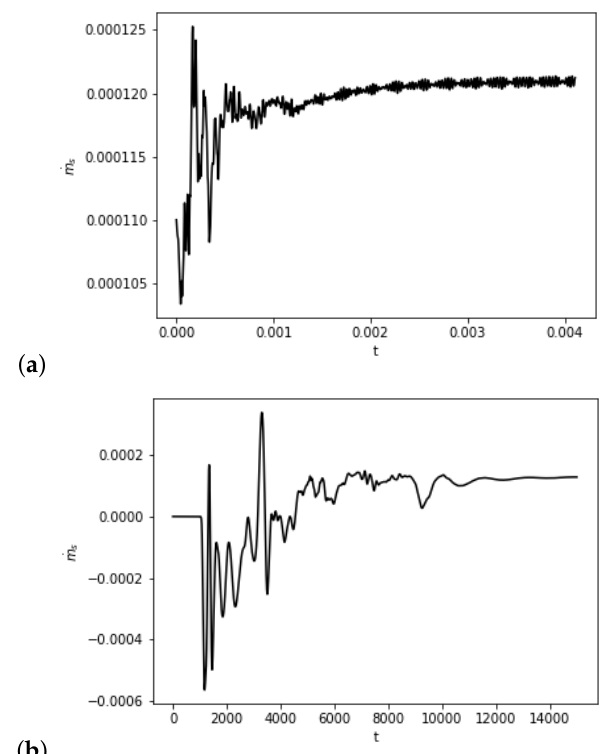
Figure 5. Performance of CFD solvers for 1 atm in outlet boundary condition. ( a ) Transient explicit rhoCentralFoam solver converges for about t = 0.003s. ( b ) Steady-state implicit HiSA solver converges for about 15,000